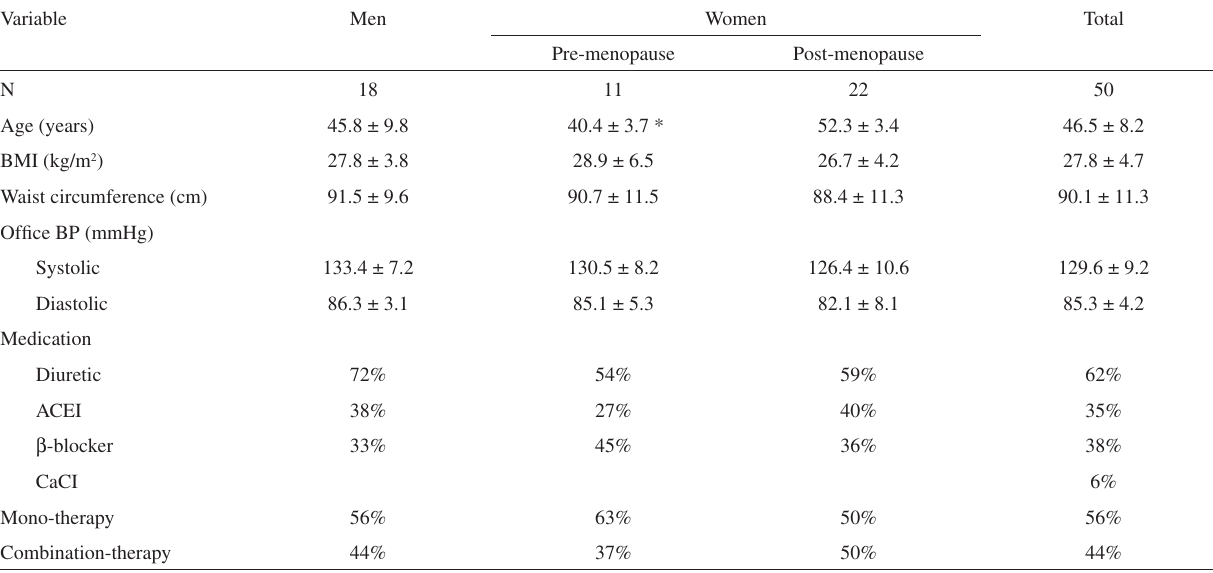
Table 1 - Subjects’